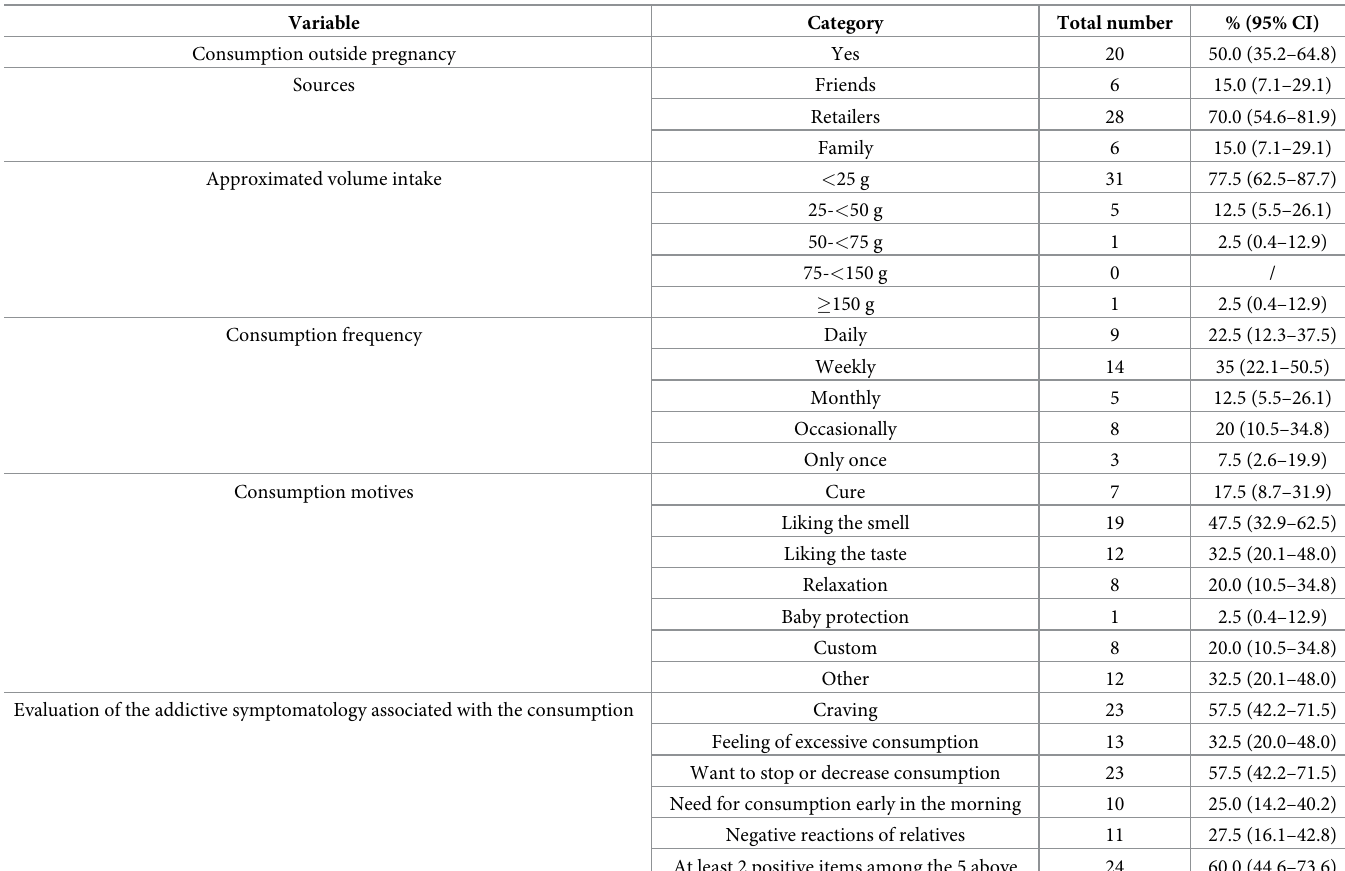
Table 4. Characteristics of kaolin consumers (N = 40) and their consumption.